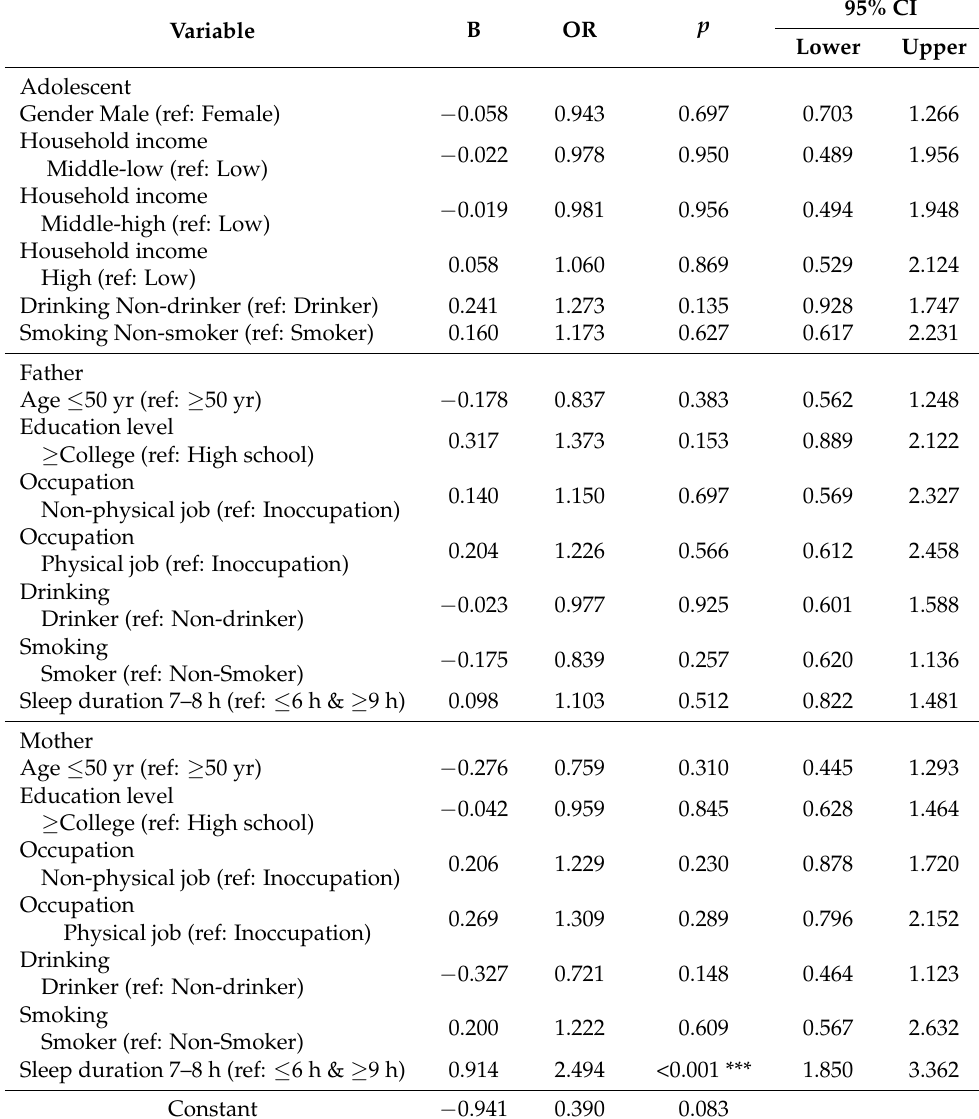
Table 5. Factors affecting 7–8 h sleep duration (ref: ≤ 6 h & ≥ 9